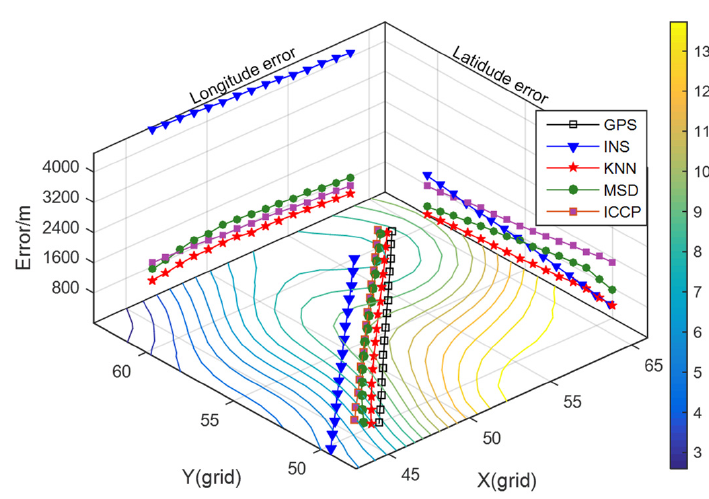
Figure 10. Matching results of track 3. Table 6. Statistics of positioning errors of track 3/m.